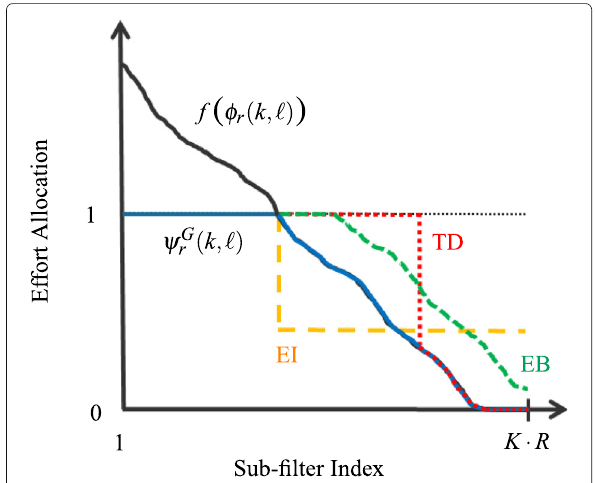
(cid:15) (cid:16) φ ( k , (cid:2)) and corresponding ψ G r ( k , (cid:2)) , r